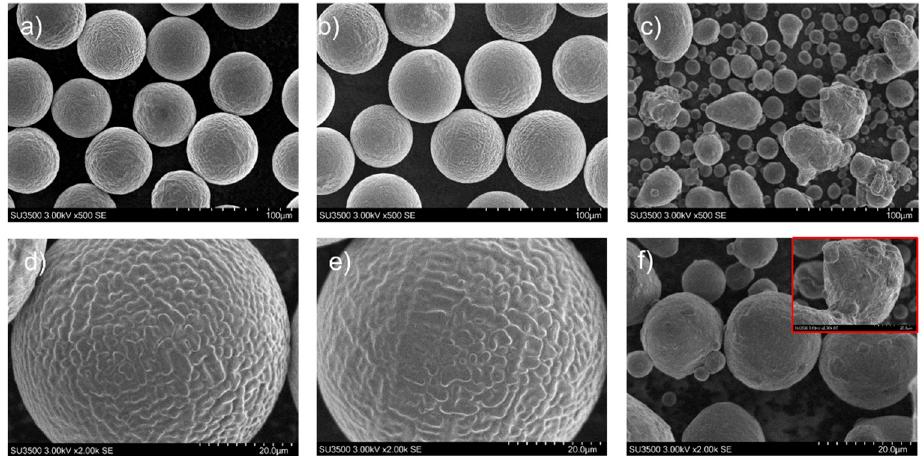
Figure 1. Representative micrographs of the powders tested within this study: (a) powder A, (b) powder B, (c) powder C, and corresponding high magnification images of (d) powder A, (e) powder B, (f) small particles of powder C. The red square in image (f) , corresponds to the high magnification image of large particles encountered on image (c) .